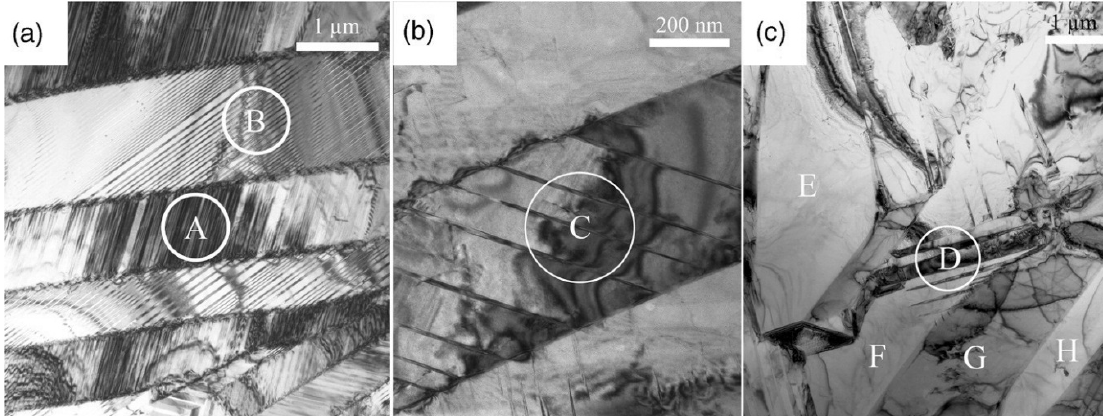
Figure 18. Evolution of microstructure with composition: ( a ) internally twinned martensite plates in Ti 50 Ni 25 Pd 25 , A, B; ( b ) plate in Ti 50 Ni 30 Pd 20 with a smaller twin ratio, C; ( c ) example of microstructure in Ti 50 Ni 39 Pd 11 composed of a mosaic of twinless martensite plates (denoted E, F, G, H) and a group of compound twins (D) [138], with copyright permission from © Taylor and Francis .